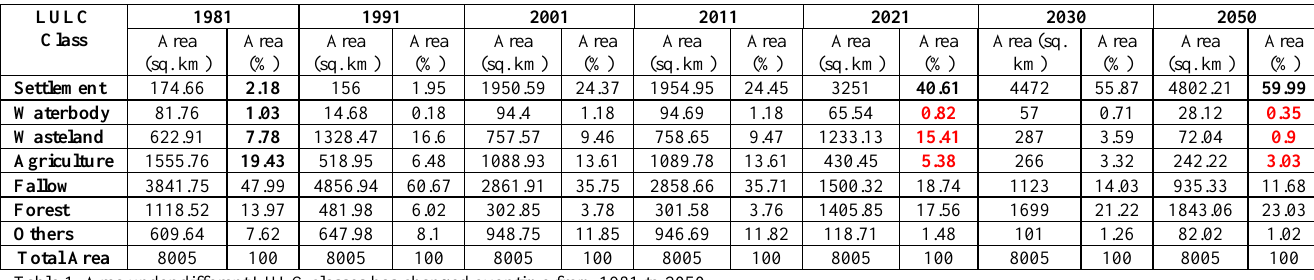
Table 1: Area under different LULC classes has changed over time from 1981 to 2050.